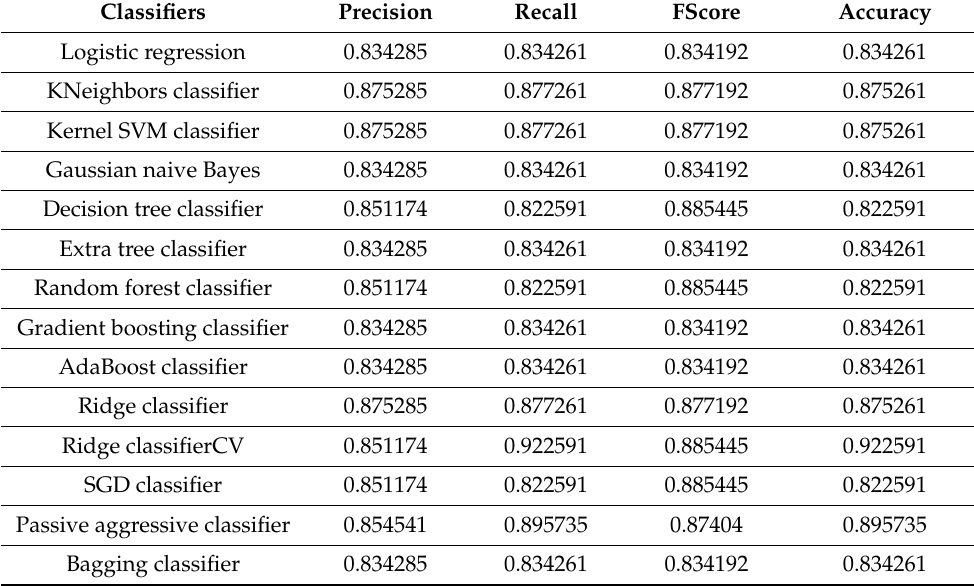
Table 20. Gradient boosting classifier metrics after feature scaling.